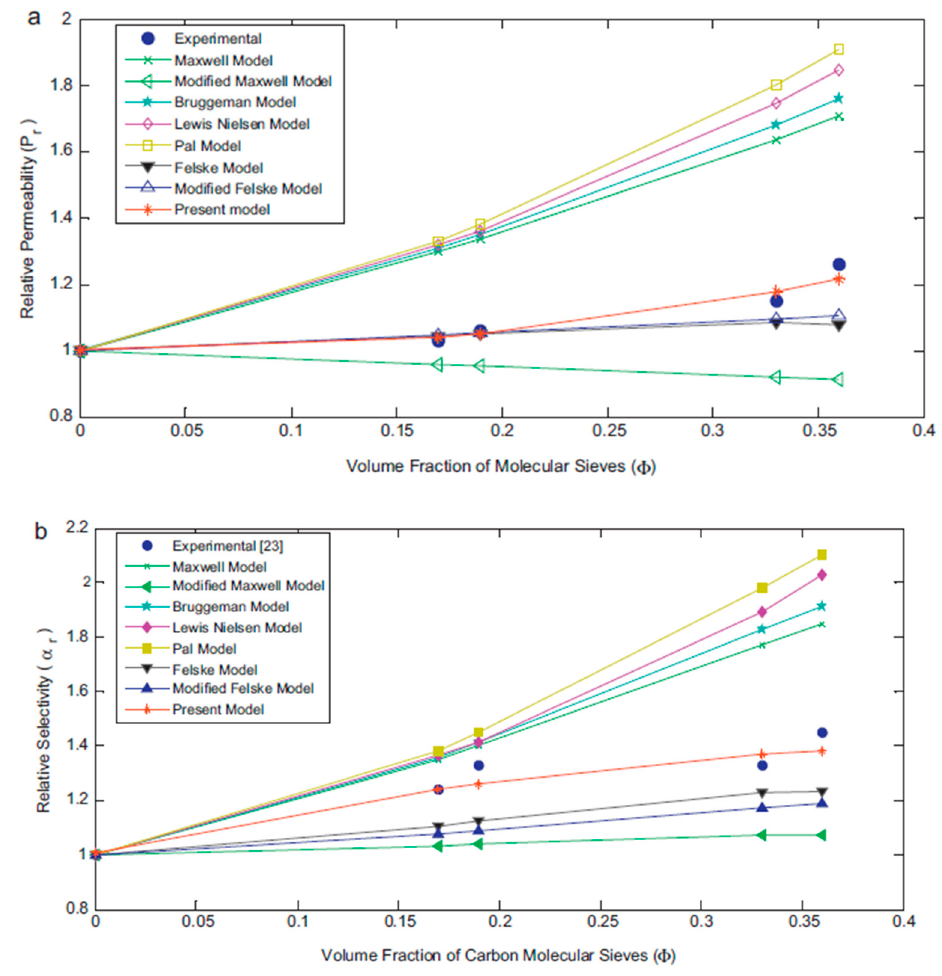
Figure 4. Comparison of the theoretical ( a ) permeability and ( b ) selectivity predicted from different models with the experimental data of CO 2 and CH 4 in carbon molecule sieves (CMS)/Matrimid MMM. Reproduced with permission from Ref. [73] Copyright 2011 Elsevier.